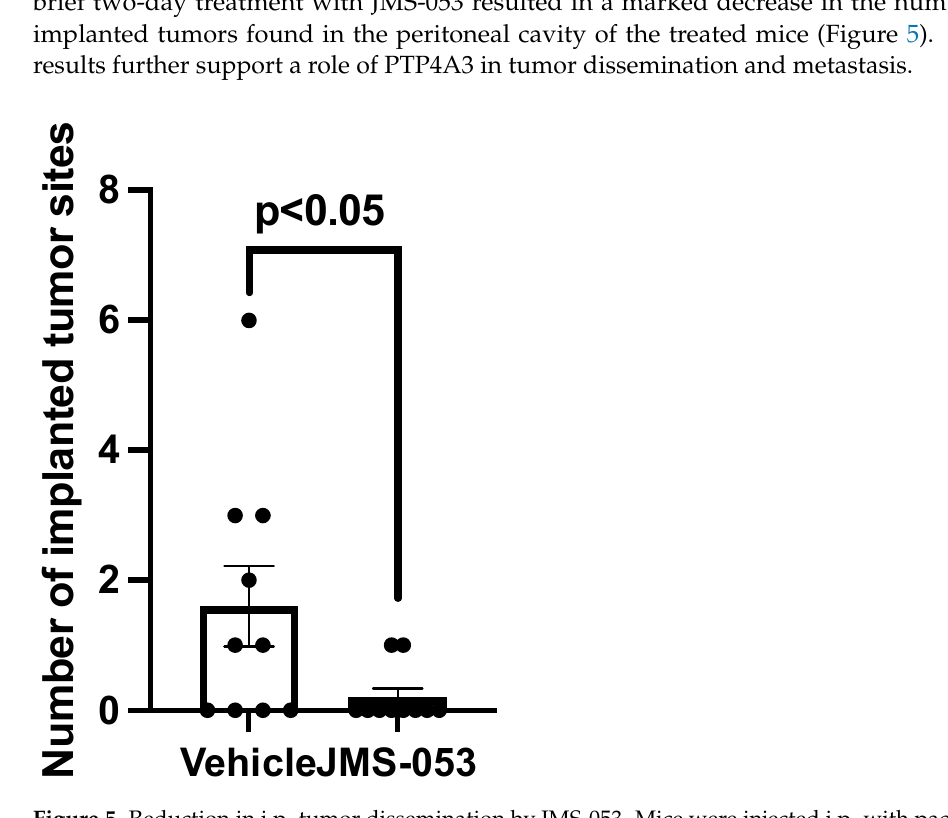
Figure 5. Reduction in i.p. tumor dissemination by JMS-053. Mice were injected i.p. with paclitaxel-resistant SKOV3-TRip2 cells that were briefly (1 h) incubated with 5 μM JMS-053 or vehicle and followed with i.p. treatment with 15 mg/kg JMS-053 one and two days later. Mice were sacrificed 14 days after tumor cell injection and the number of i.p. tumors counted. Individual values are indicated as well as the mean value ± SEM. Unpaired Student t -test. * p < 0.05